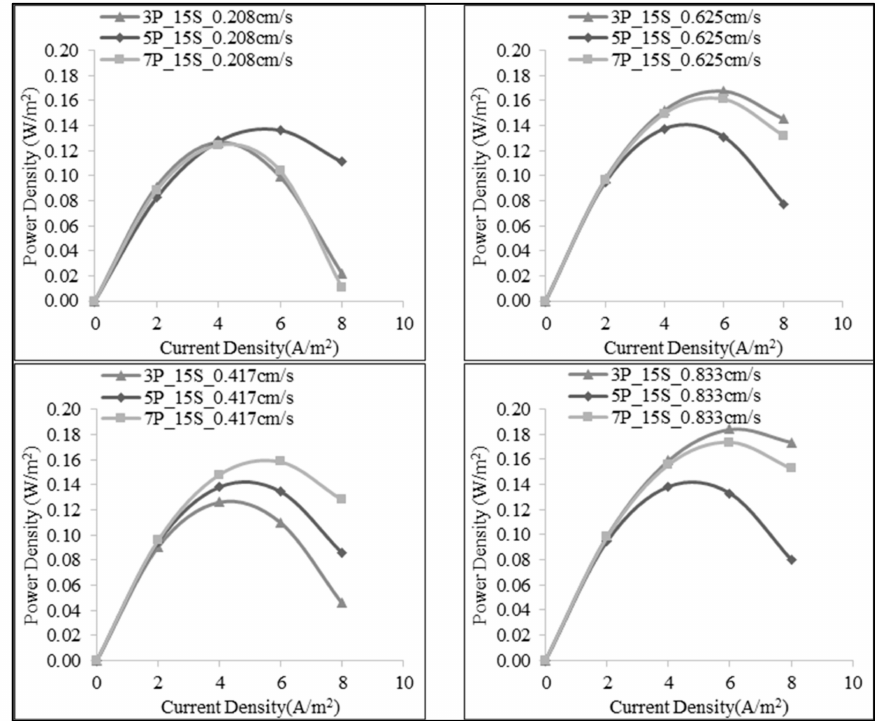
Figure 3. Effect of the number of the membrane pair on power density for the salinity ratio of 1:15 (XP_YS_Zcm/s indicates X membrane pair, Y salt content of HSS and Z feed velocity).